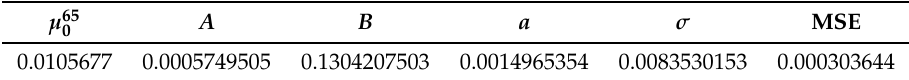
Table 1. Calibration parameters of the HW model using